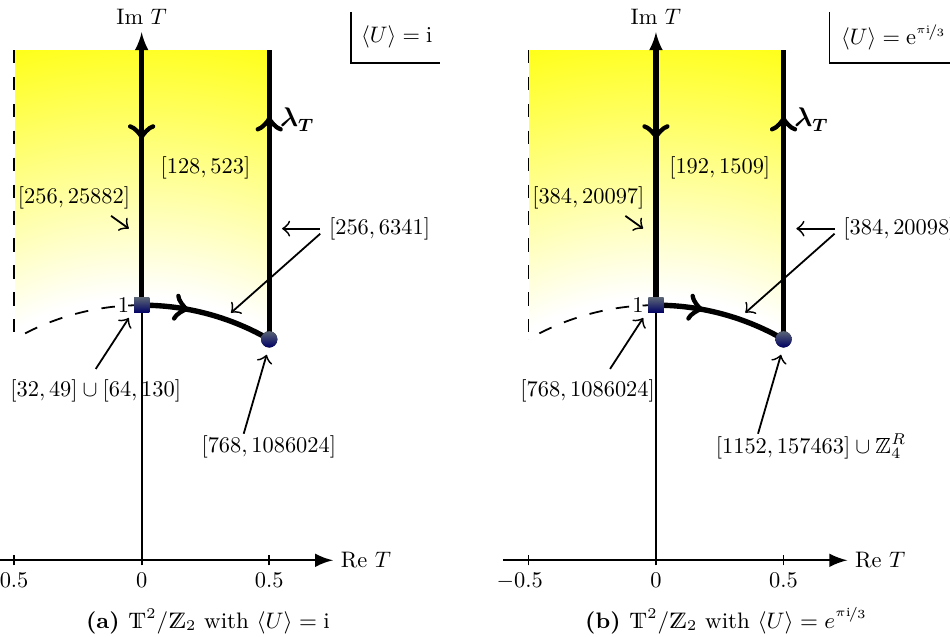
Figure 2. Unified flavor groups at different points h T i and the boundary λ T of the fundamental do- main of SL(2 , Z ) for two special vevs h U i of the complex structure modulus. We use the shorthands T [32 , 49] ∪ [64 , 130] ∼ = (cid:2) [32 , 49] × [64 , 130] (cid:3) / Z